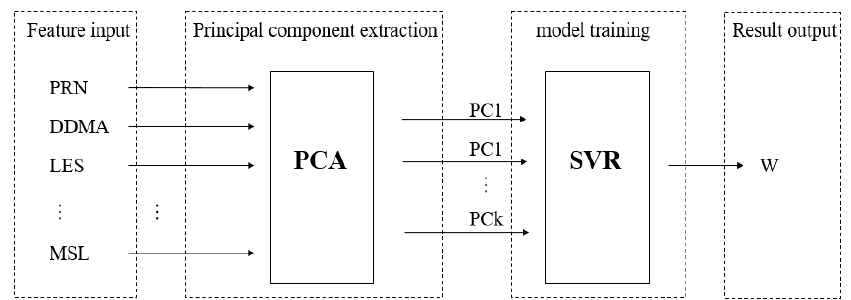
Figure 1. PCA-SVR model structure.